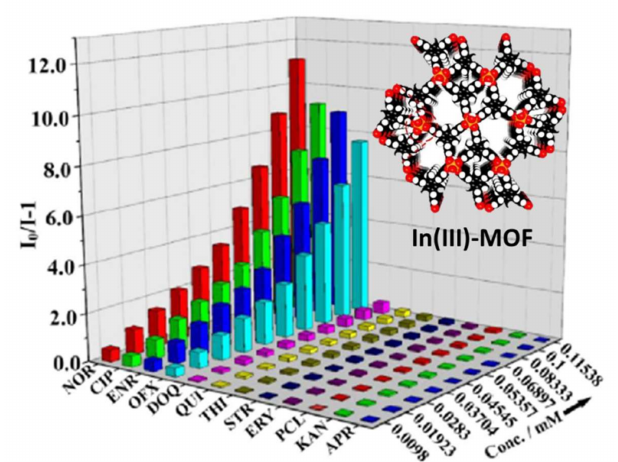
Figure 15. Quenching efficiencies of the tested antibiotics at different concentrations on the fluores- cence of In(III)-MOF at room temperature; inset: the structure of In(III)-MOF. Adapted from